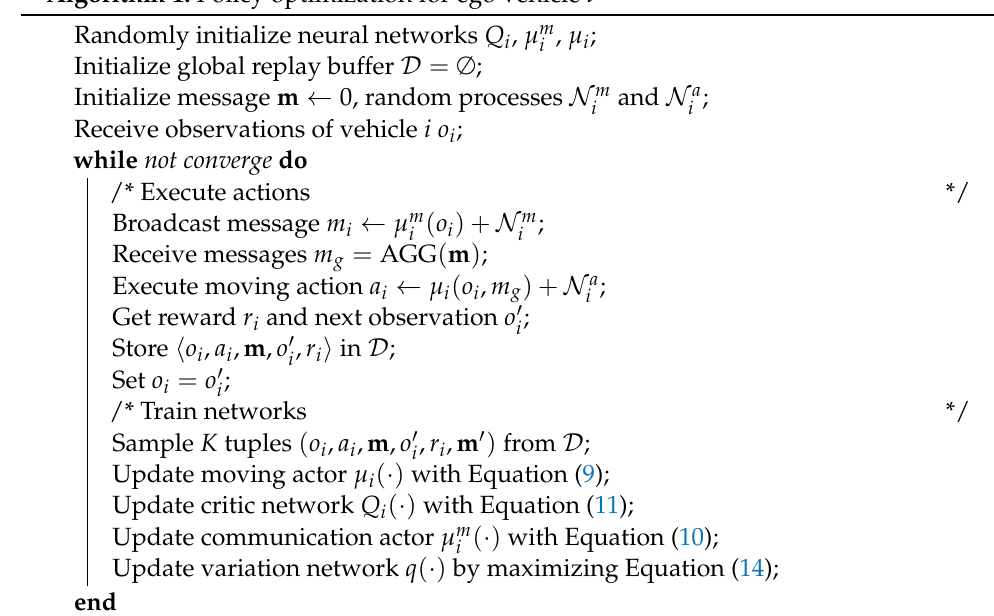
Algorithm 1: Policy optimization for ego vehicle